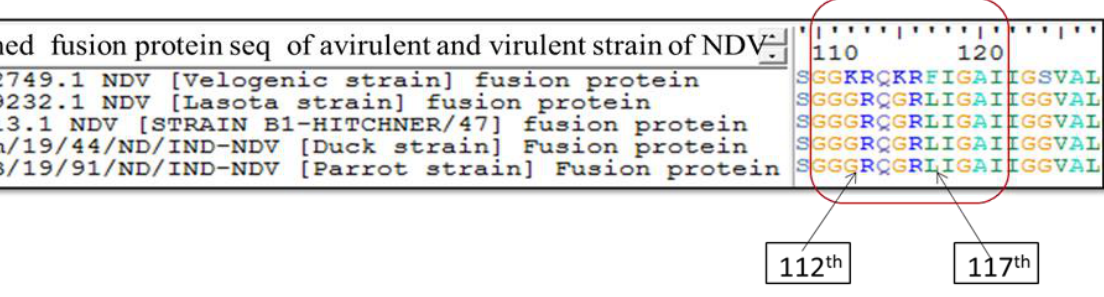
Figure 3. F protein cleavage site analysis for pathotyping of Newcastle disease virus isolates from duck (As/Km/19/44) and parrot (As/WB/19/91).